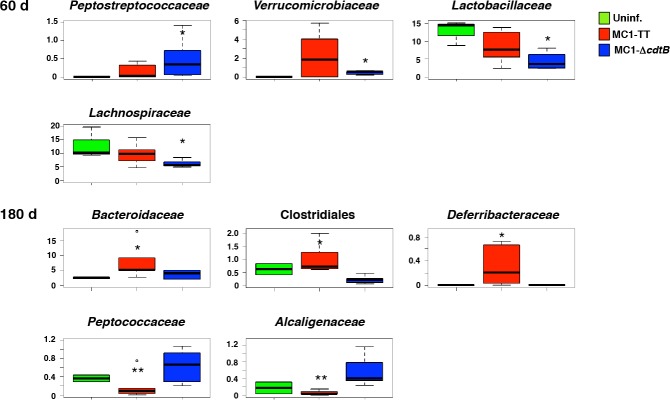
Phylogenetic analysis of the intestinal microbiota.Relative abundance of the significantly altered bacterial families in the intestinal microbiota of mice infected with the MC1-TT (TT) or MC1-ΔcdtB (ΔcdtB) strain compared to uninfected mice. *p value ≤ 0.05.